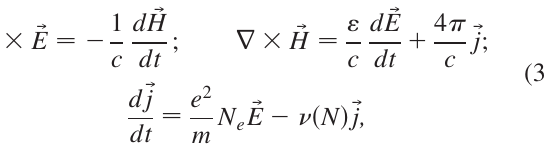
is the d is the power in the mirror m